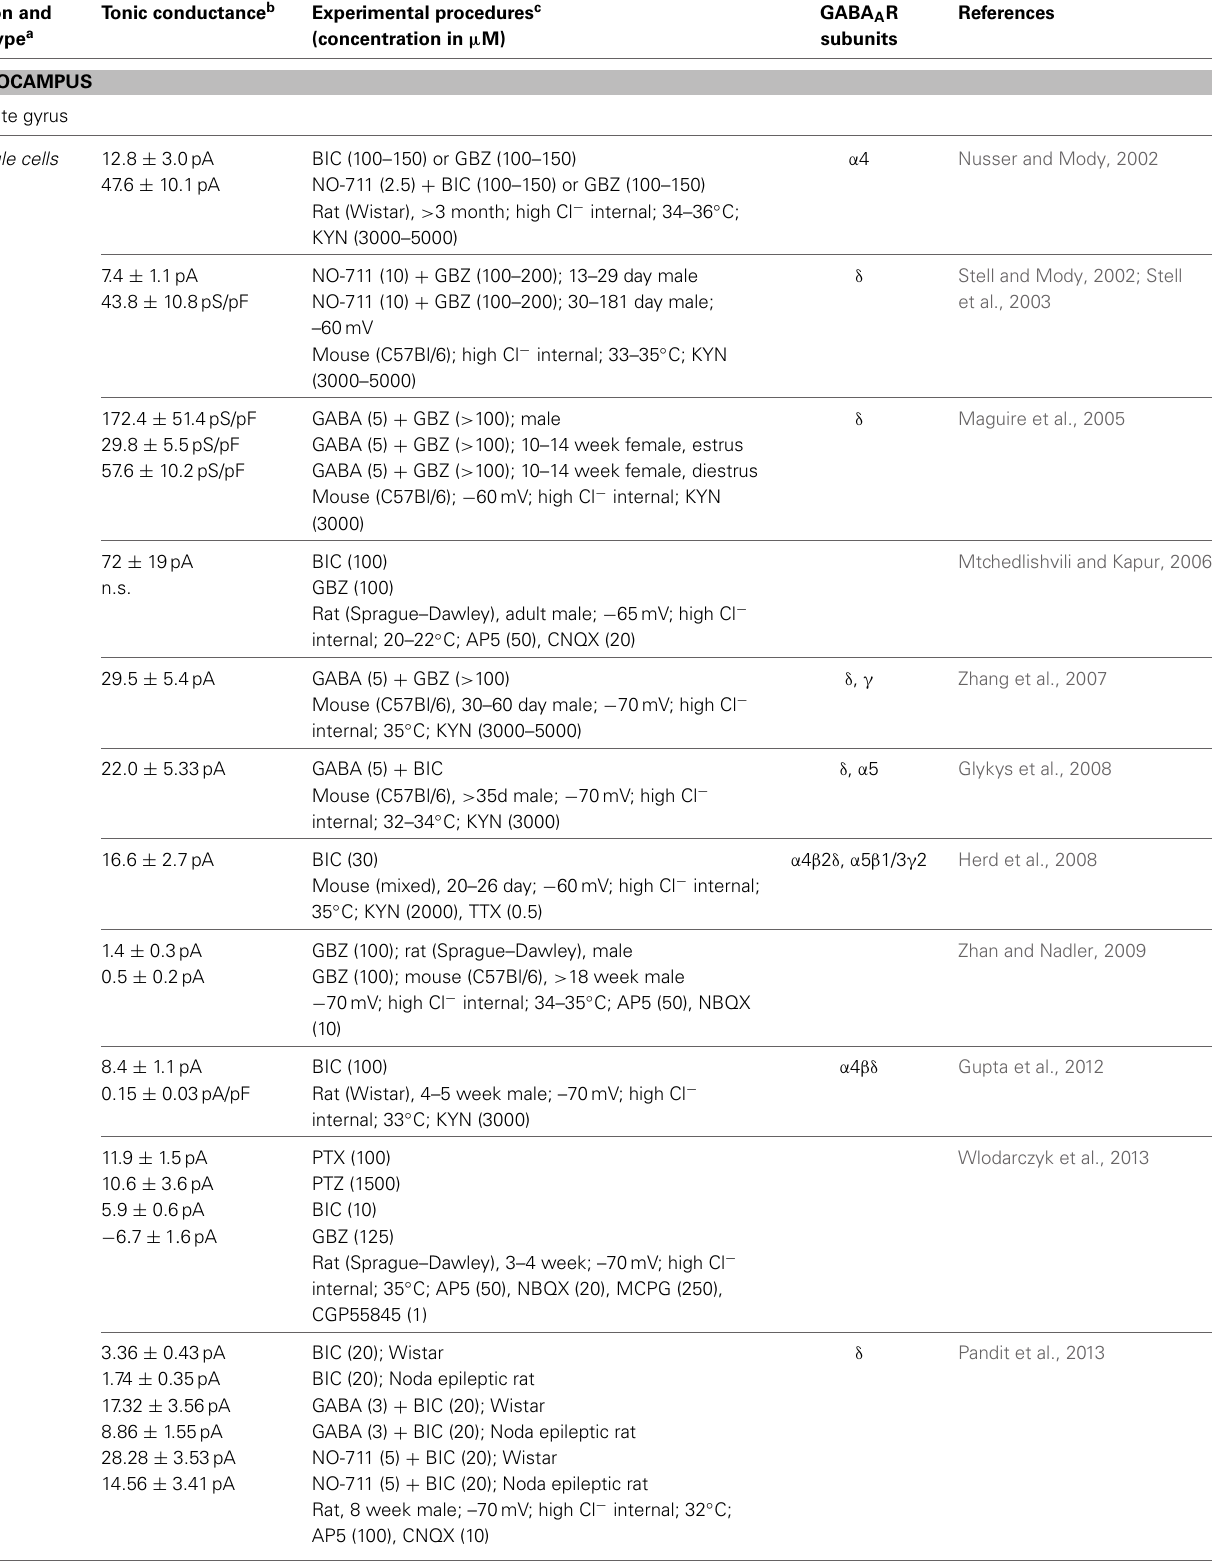
Table 1 | Levels of tonic inhibition vary across brain region and cell type in the CNS. Region and cell type